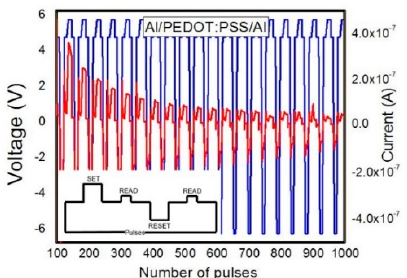
Figure 4. Endurance characteristic of Al / PEDOT:PSS / Al; the inserted picture depicts the pulsing sequences utilized for write / read / erase / read test.